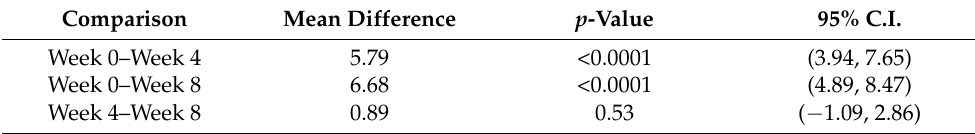
Table 1. Results of Tukey’s multiple comparison procedure for PSS.